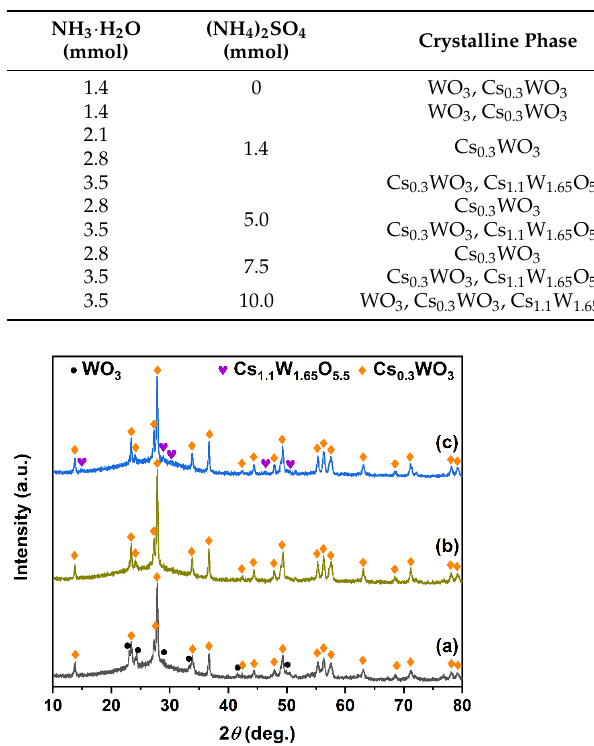
Table 1. The crystalline phases, starting pH values, and the mass percentages of Cs 1.1 W 1.65 O 5.5 of the systems conducted at 200 ◦ C for 24 h using 0.18 mmol CsCl, 0.4 mmol WO 3 , 8.8 mmol CH 3 CH 2 CHO, and different amounts of NH 3 · H 2 O and (NH 4 ) 2 SO 4 .